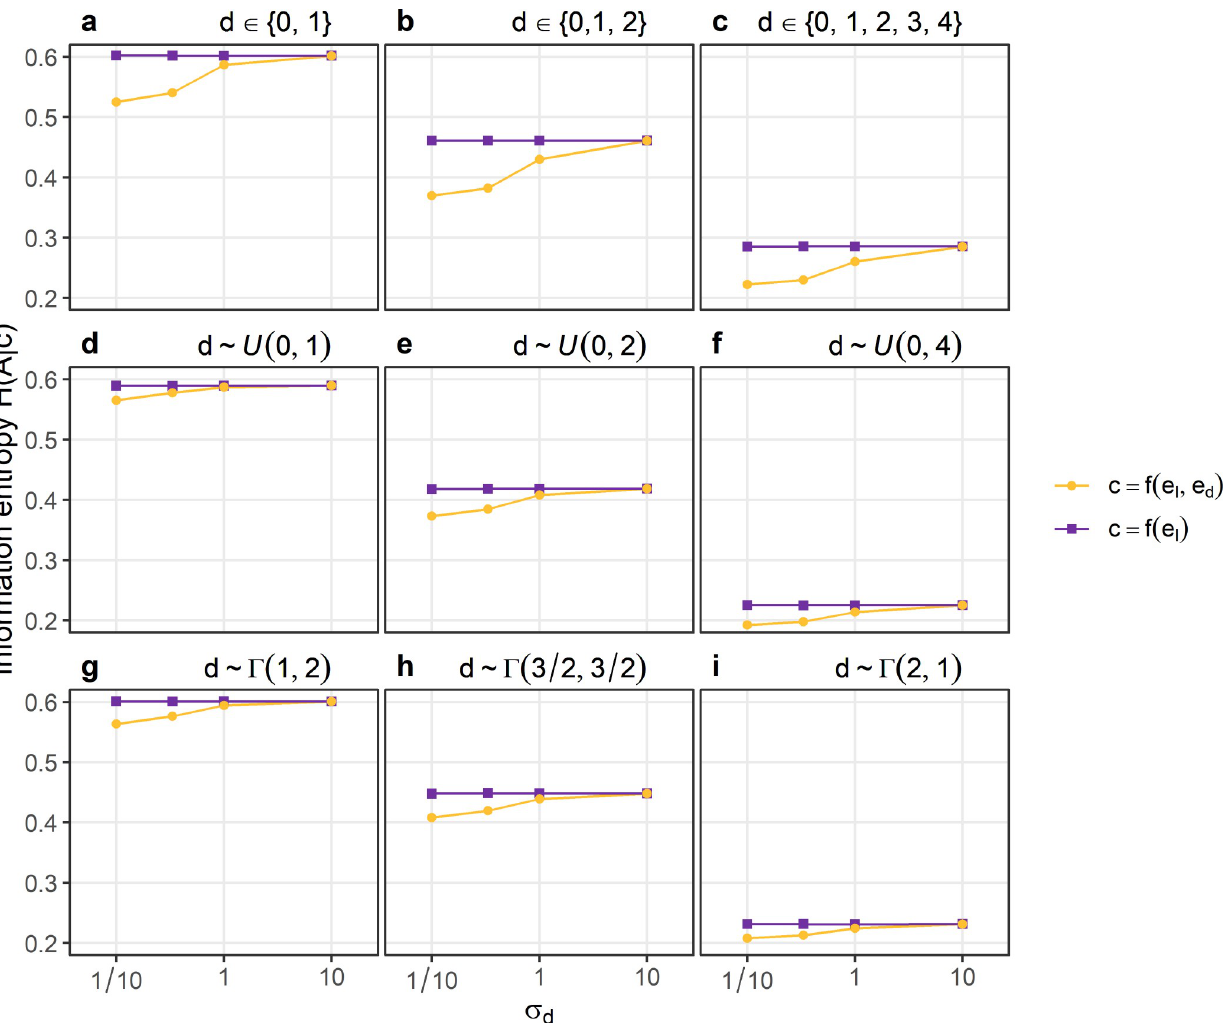
Fig 7. The information entropy of choice accuracy conditioned on confidence H(A|c). The noise parameters of the estimate of discriminability σ d is displayed on the x-axis. Different panels indicate different distributions of discriminability within the simulated experiments. Panels a-c: Discrete uniform distributions. Panels d-f: Continuous uniform distributions. Panels g-i: Gamma distributions. Violet symbols indicate H(A|c) when confidence is calculated exclusively based on sensory evidence about the identity of the stimulus e I . Orange symbols indicate H(A|c) when confidence is calculated based on evidence about the identity of the stimulus e I and on evidence about discriminability e d . The standard deviation of evidence about the identity σ I was set to 1.